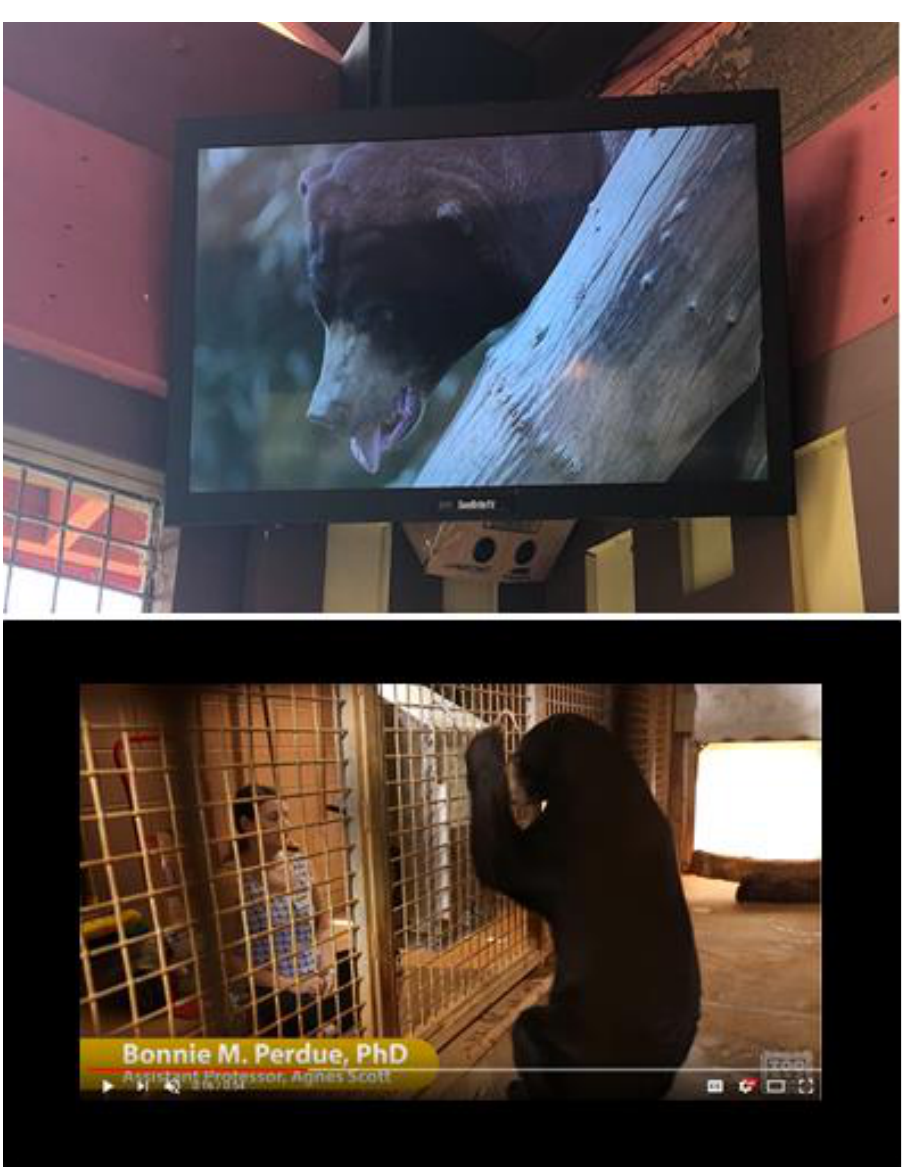
Top Panel: Monitor Playing Scientific Video or Enrichment Video in the Sun Bear and Tiger Terrace. Bottom Panel: Screenshot from the Scientific Video Condition Illustrating Cognitive Research with Sun Bears at Zoo